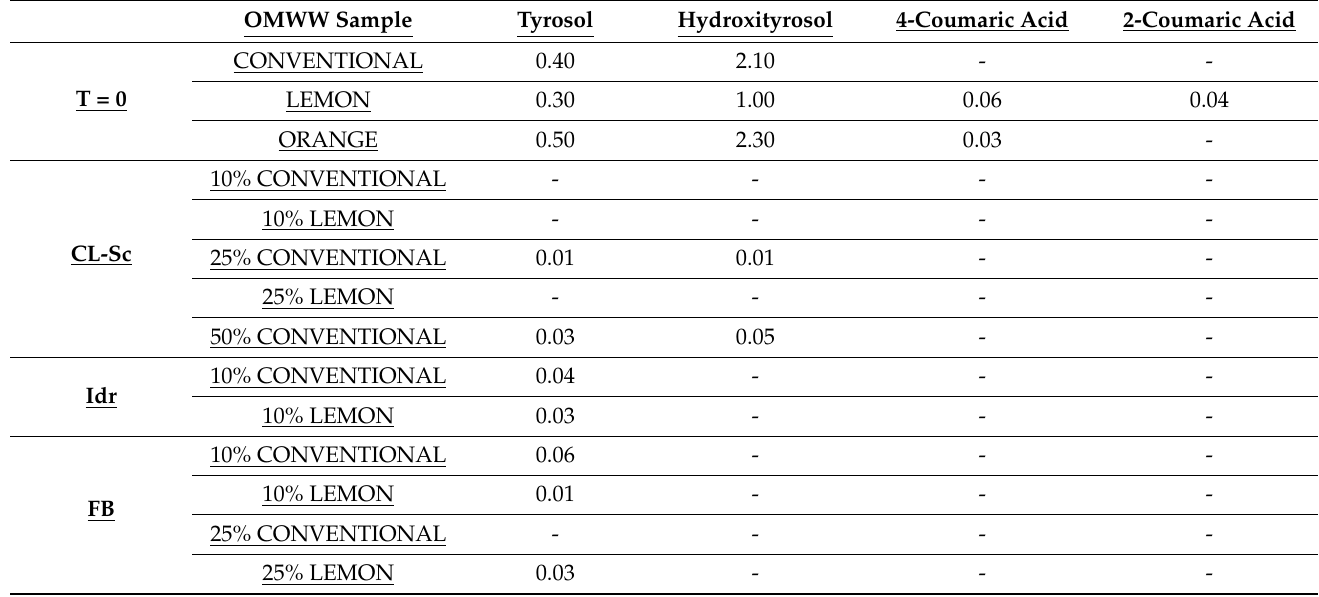
Table 4. Amount (mg) of identified phenolic compounds in the control (t = 0) and CL-Sc, Idr and FB cultivation at 10%, 25% and